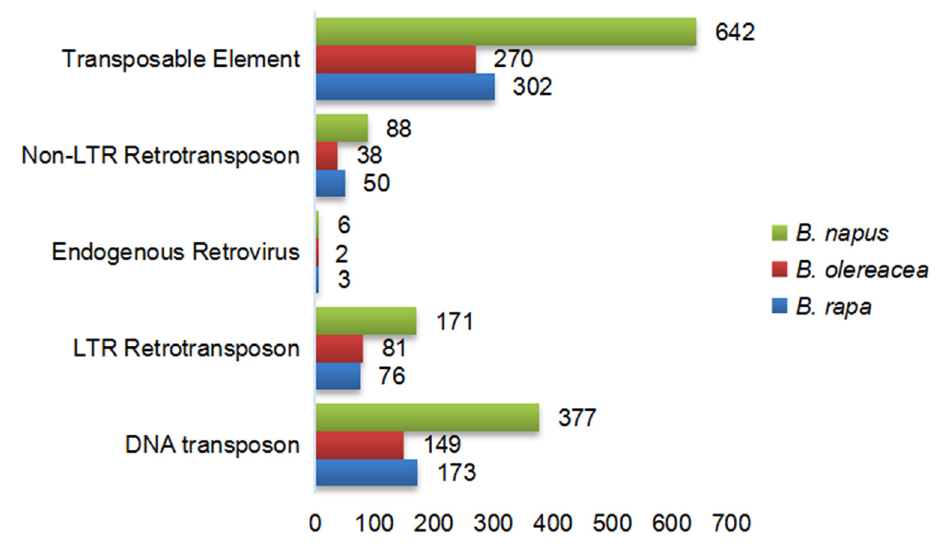
Figure 7. The number of TEs around 2000 bp upstream and downstream of SUV genes in B. rapa , B. oleracea and B. napus.